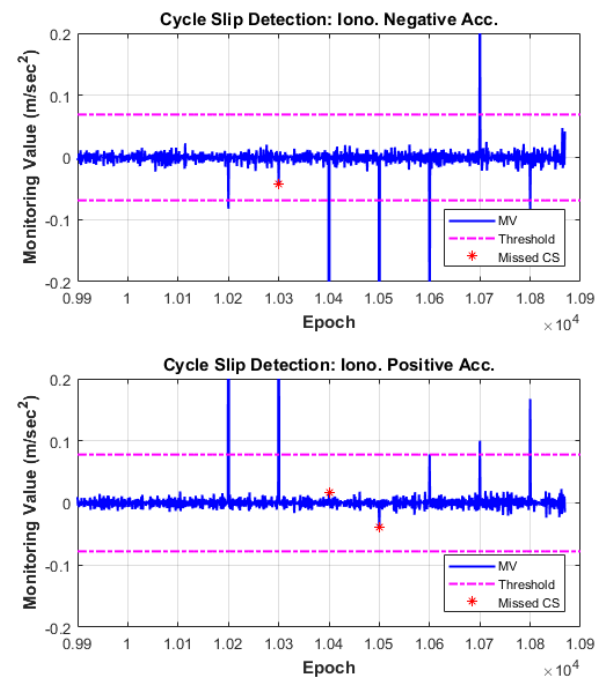
Figure 10. Cycle-slip detection results for G14.